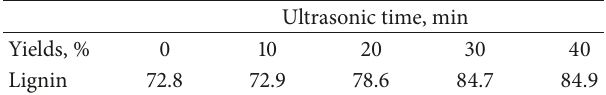
Table 2: The yield of lignin obtained by alkaline and ultrasonic- assisted alkaline extraction of rice straw with 2 M NaOH at 90 ∘ C for 1.5 h.